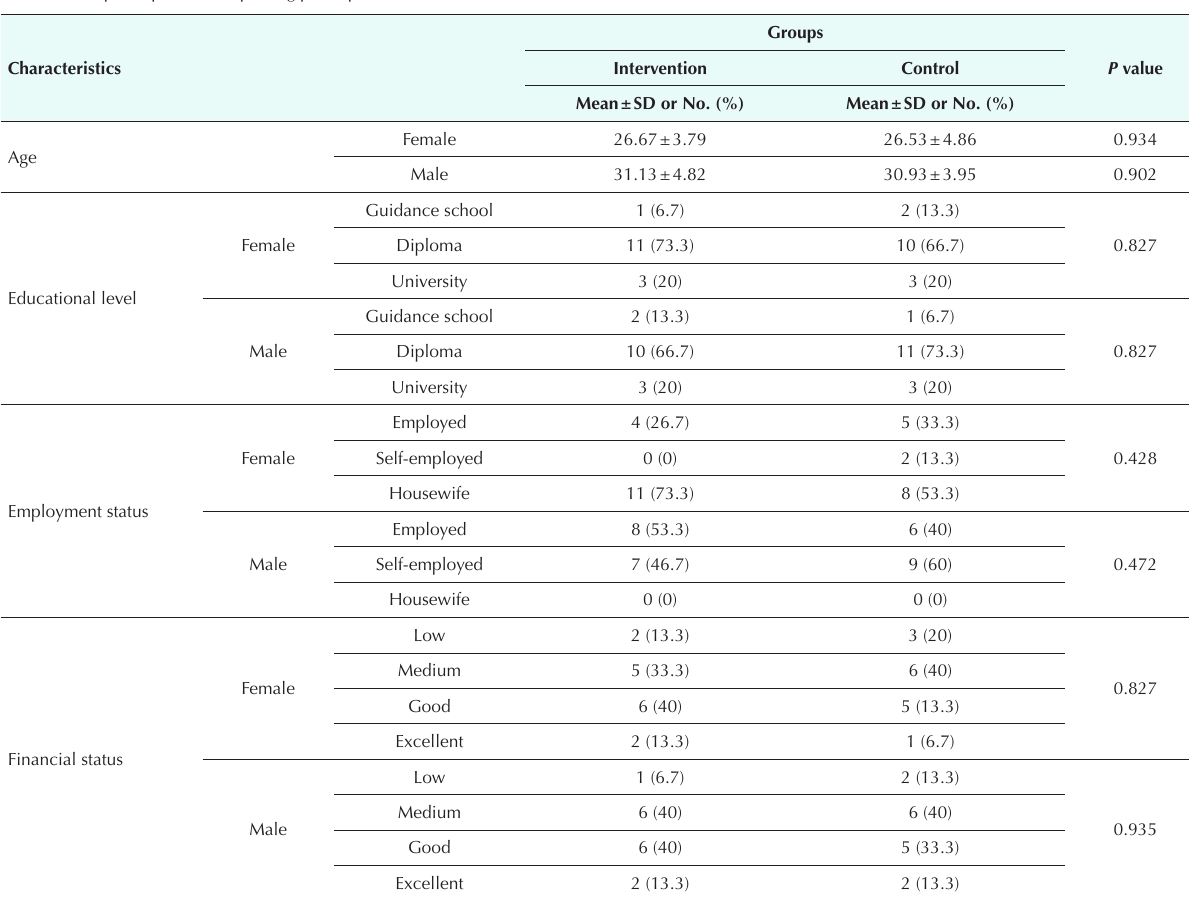
Table 2. Group comparisons respecting participants’ characteristics